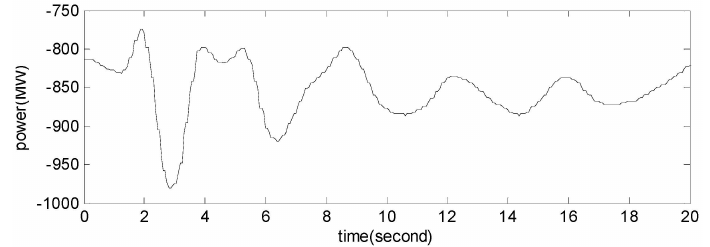
Figure 15. Active power of the Jiangjiaying-Gaojiang 1st line.